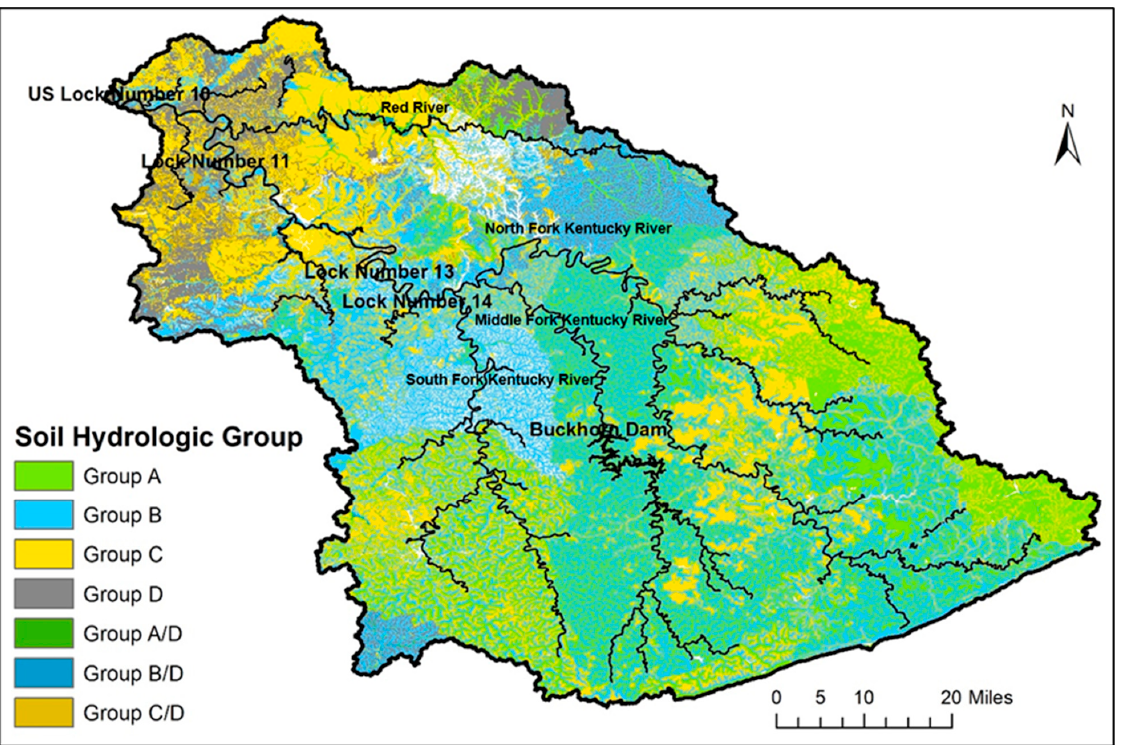
Figure 5. Map of Hydraulic Soil Group in the Upper Kentucky River Basin.